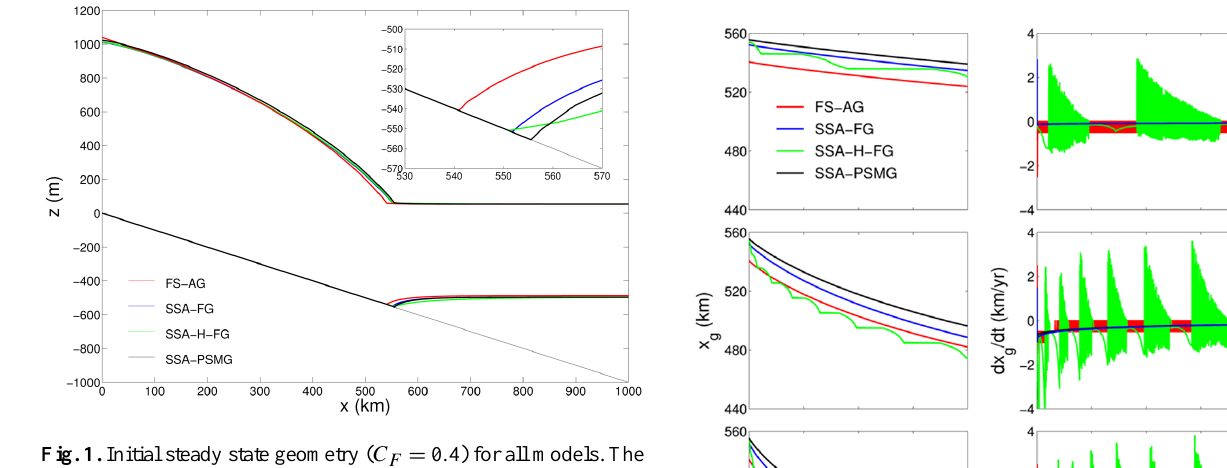
Fig. 1. Initial steady state geometry ( C F = 0 . 4) for all models. The inset emphasizes the differences in GL position. SSA–H-FG lower surface has a quite different shape with respect to the three other models due to its coarser resolution (10 km).